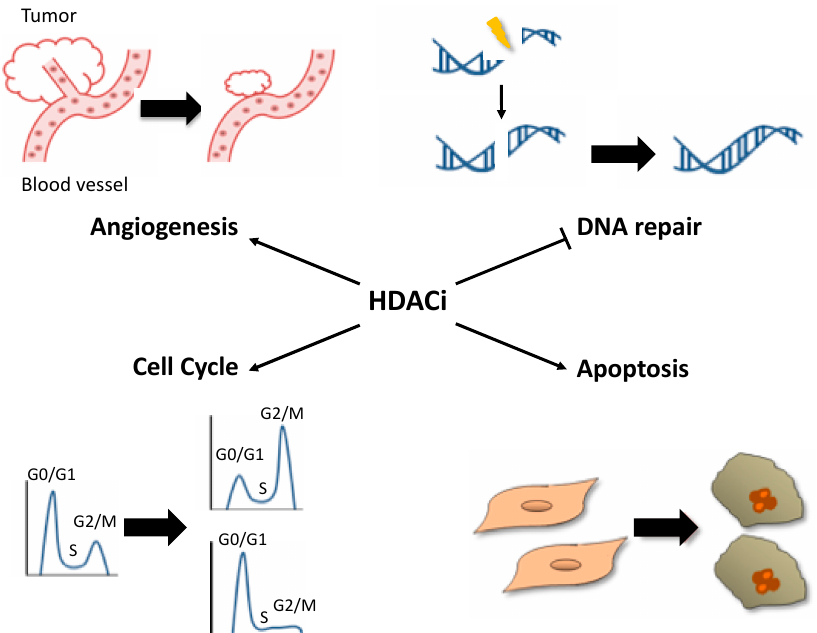
Figure 1. The main cellular processes affected in cancer cells by HDACi treatments. The decrease of histone acetylation by HDACi leads to the modification of the expression of several genes implicated in oncogenic properties of cancer cells. From top left to bottom right, HDACi reduces angiogenesis and tumor growth, HDACi improves treatments by inhibiting DNA repair, HDACi induces cell cycle arrest and stimulates apoptosis.